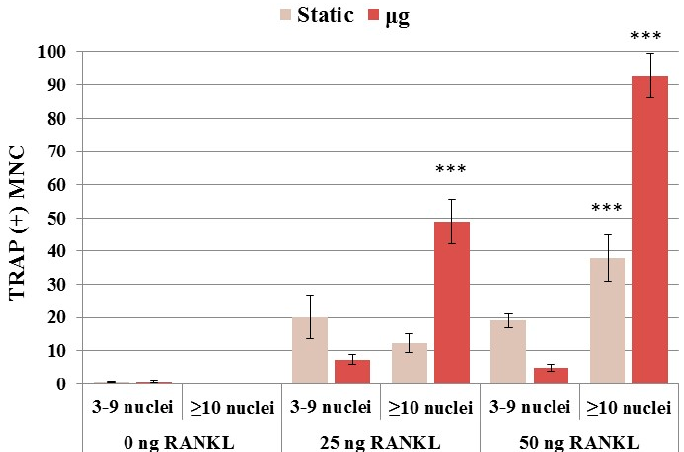
Figure 2. RANKL-dependent multinucleated cells formation under static and simulate microgravity. multinucleated cells (MNCs) with ≥ 10 nuclei significantly increases in microgravity compared to static condition (two-way ANOVA: p < 0.0001). The number of MNCs containing ≥ 10 nuclei increased significantly with increasing RANKL concentration in both static (one-way ANOVA: p = 0.0002) and microgravity (one-way ANOVA: p = 0.0001) conditions. Stars mean statistical significance compared to the corresponding control using Dunnett´s multiple comparison test (*** p < 0.005).